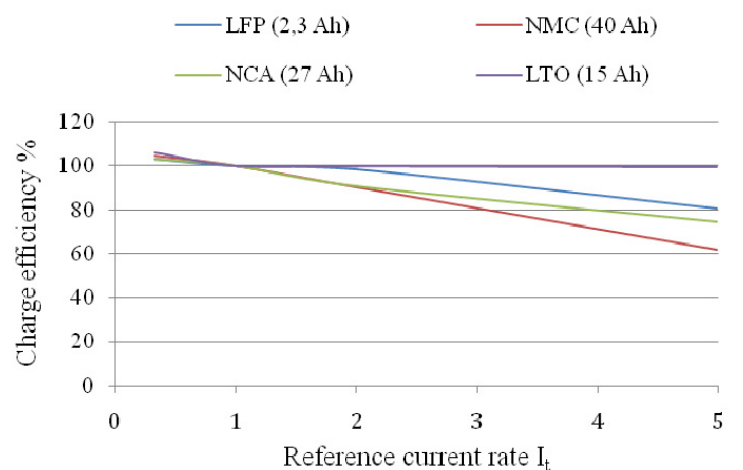
Figure 6. Charge efficiency during CC phase at cell